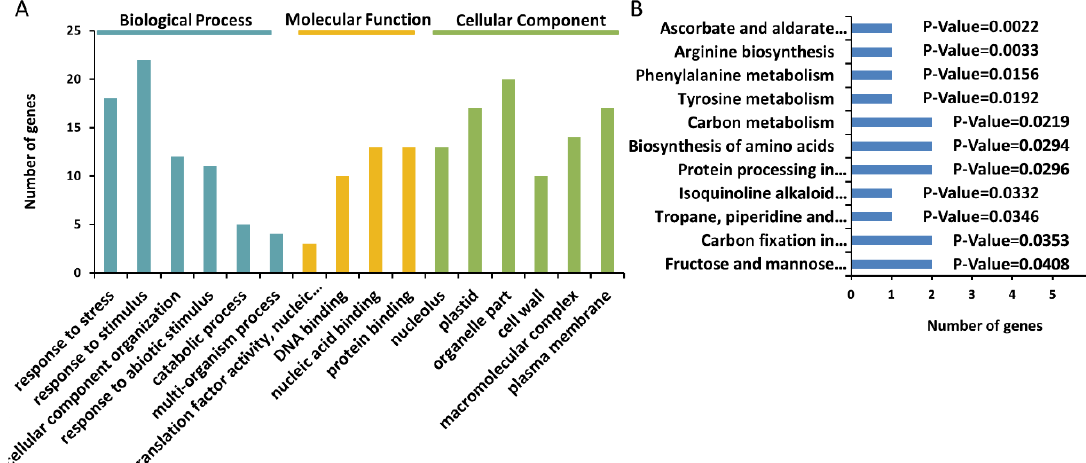
Figure 5. Gene ontology (GO) annotation function ( A ) and Kyoto Encyclopedia of Genes and Genomes (KEGG) ( B ) analyses of the identified proteins from the black layer.